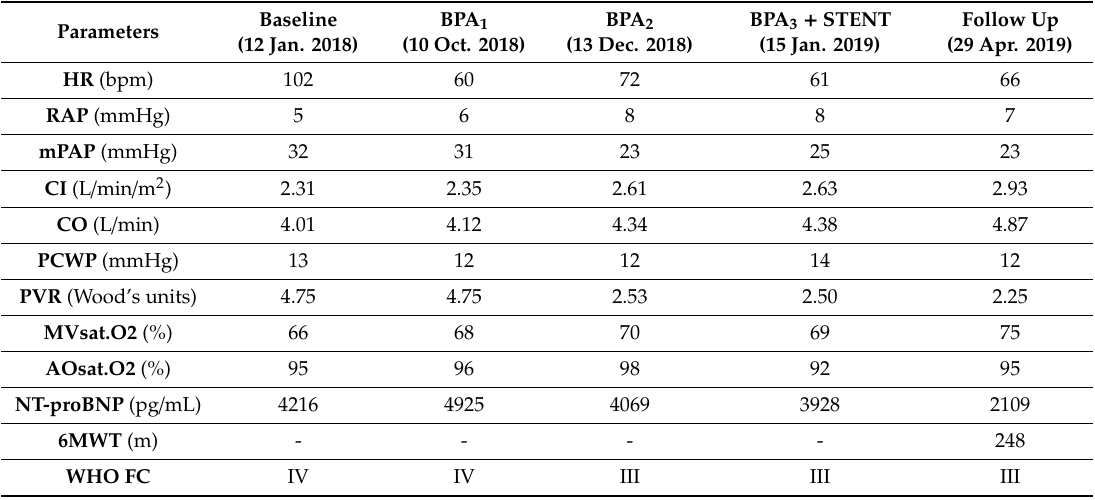
Table 1. Hemodynamic and functional parameters at baseline, during consecutive BPA sessions, and at follow up.